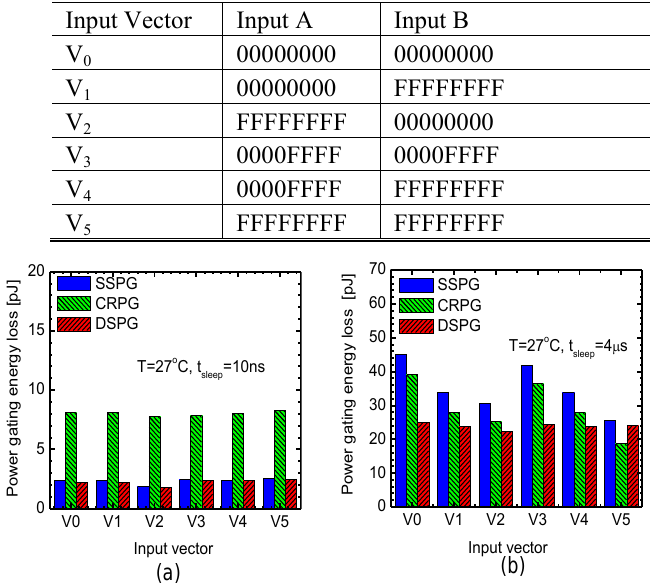
Table 1: 32-bit input vectors applied to the 32-bit carry-look-ahead adder.